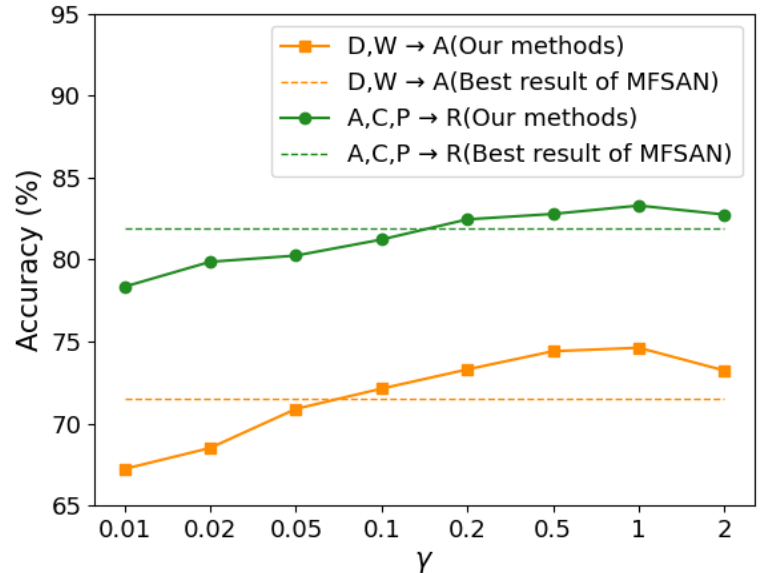
Figure 6. Accuracy with respect to γ = ρ = 100 λ